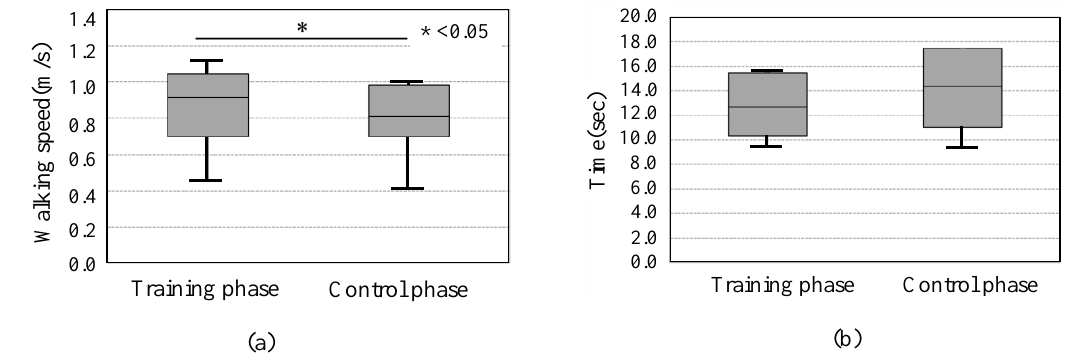
Figure 10. The score of all subjects. ( a ) 5-m walking test; ( b ) TUG Figure 7. The score of all subjects. ( a ) 5-m walking test; ( b ) TUG test